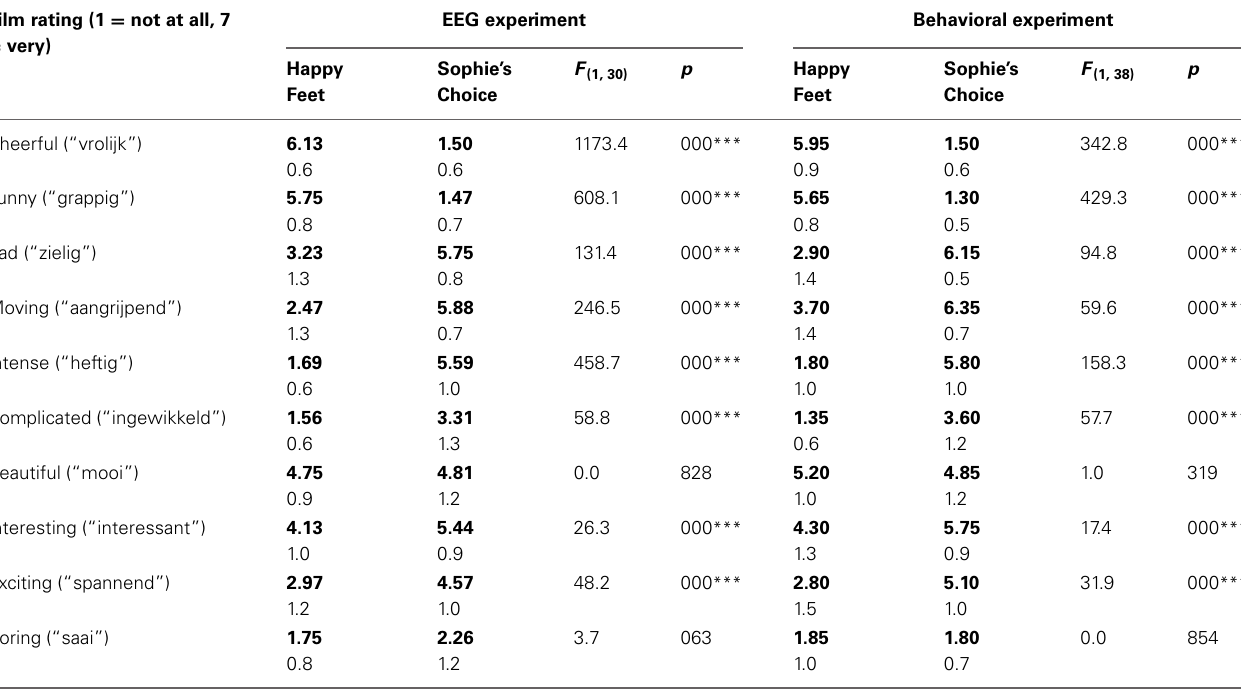
F-tests reflect differences in rating of Happy Feet and Sophie’s Choice clips, analyzed within-participants in the EEG study and between-participants in the behavioral experiment. *** p <